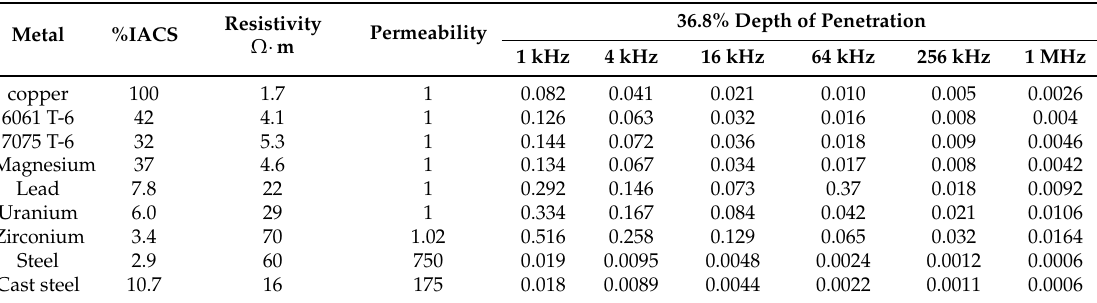
Figure 18. Skin depth effect in eddy current testing for copper: ( a ) 100 Hz exciting coil frequency; ( b ) 1 kHz exciting coil frequency [63]. Table 2. Typical Depths of penetration